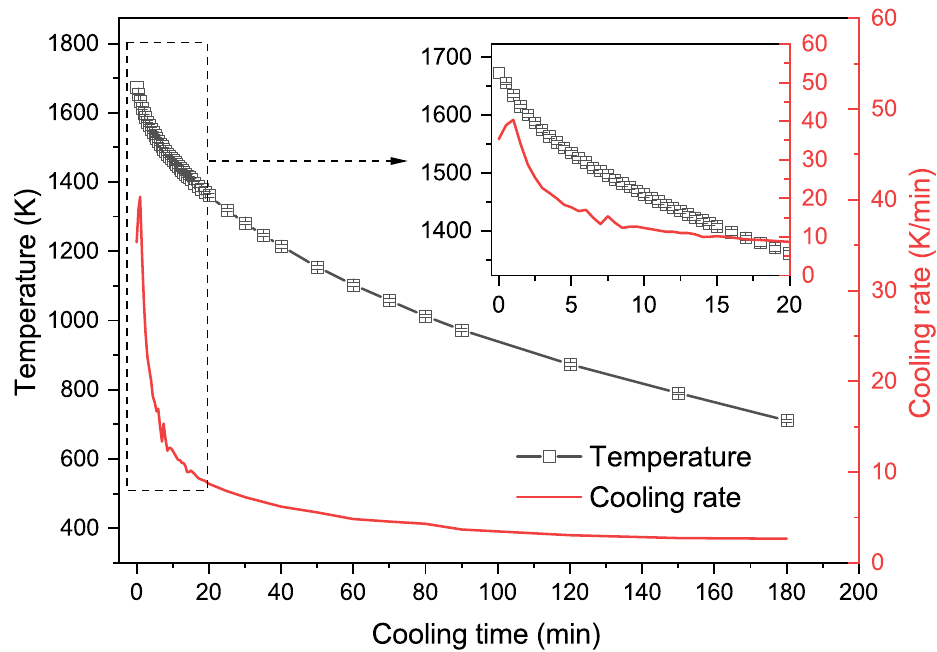
Figure A2. Temperature profile of the Carbolite HTF 1700 oven during natural cooling. The cooling rate is derived from the first-order derivative of the temperature curve. Ambient temperature: 297 ± 1K. The cooling process was conducted three times. Error bars are inside the hollow squares.